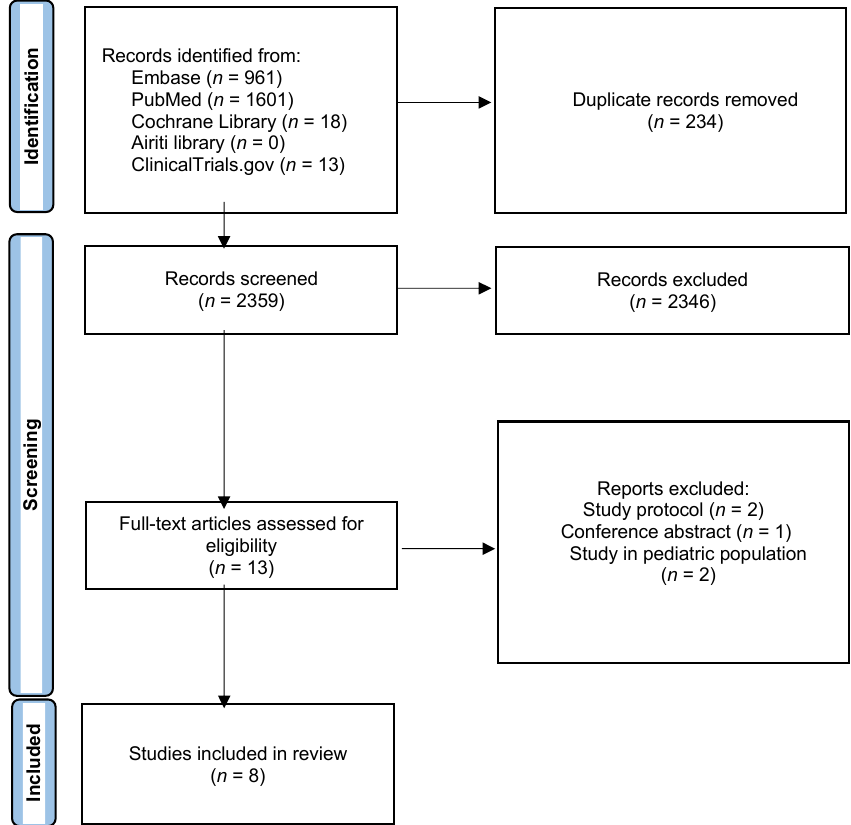
Figure 1. Study flow diagram.